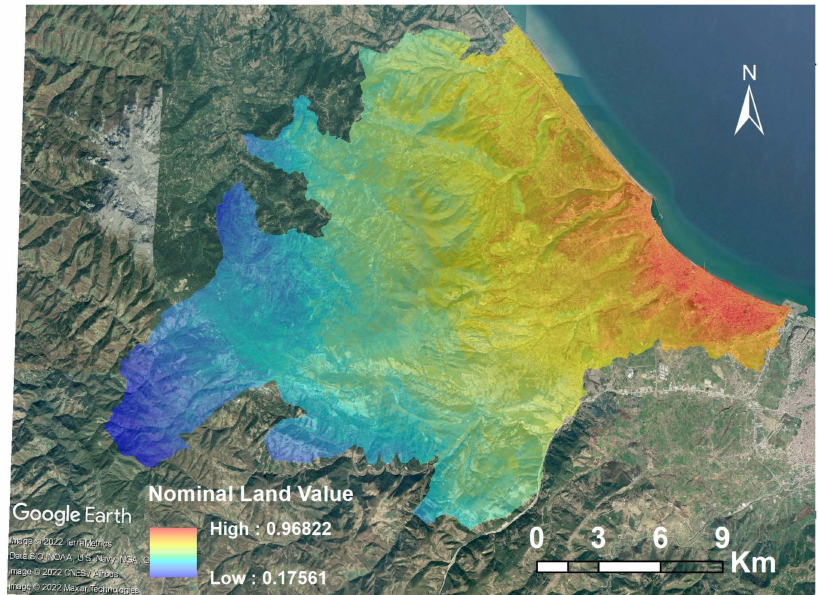
Figure 7. Nominal land value map and satellite image (Google